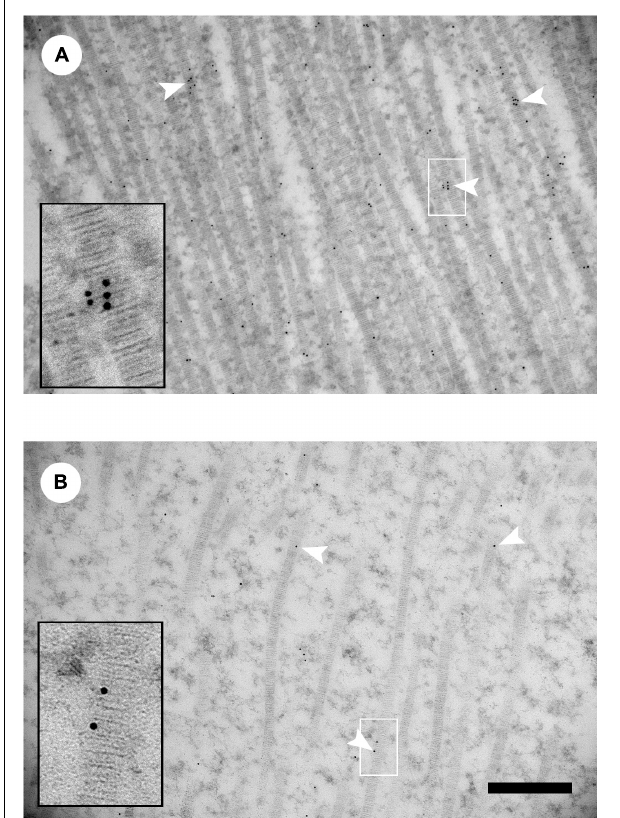
FIGURE 3 | Decorin immunogold transmission electron microscopy images of collagen fibrils from wooden breast-affected muscle of Line A (A) and Line B (B) . White arrowheads indicate gold particles labeling collagen fibrils. Insets show enlarged images of gold labeling individual collagen fibrils in the region indicated by the white box. Scale bar = 500 nm. (Figure reproduced from Tonniges et al. (2019). Avian Dis. 63,